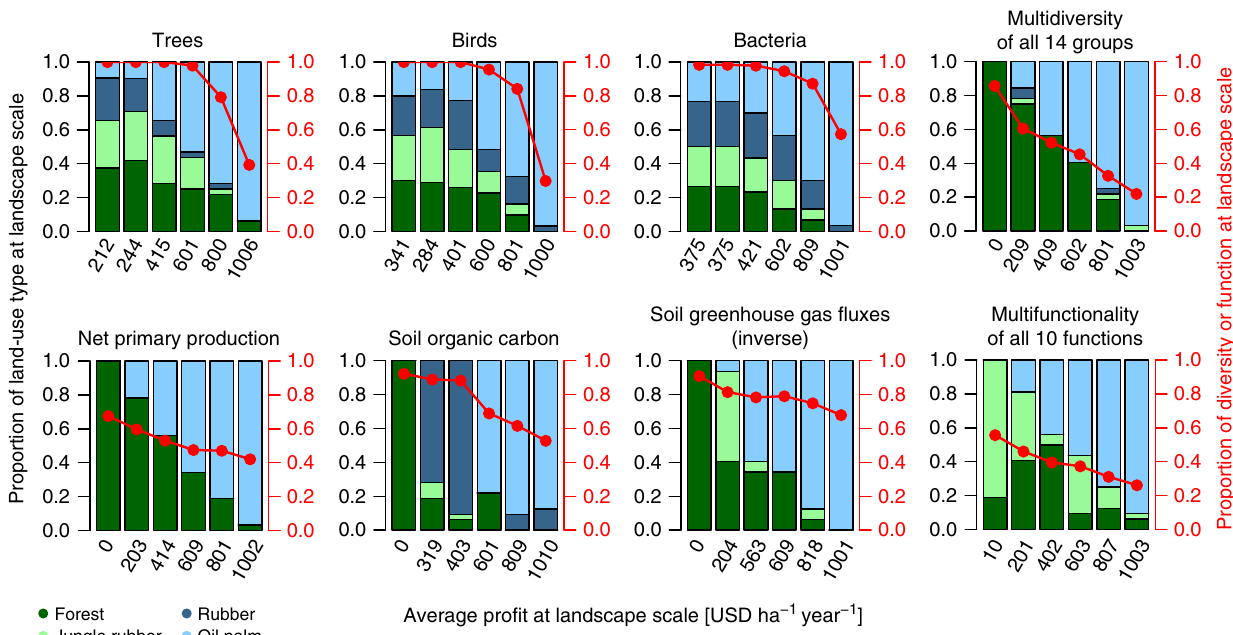
Fig. 5 Optimized landscapes for highest-possible levels of biodiversity or ecosystem functioning with increasing pro fi ts from agricultural production. Optimized landscape compositions are shown for examples of taxonomic groups and ecosystem functions as well as for multidiversity and multifunctionality considering all studied groups and functions, respectively. Each bar represents a landscape solution as identi fi ed by a genetic algorithm, fed with plot-level information on biodiversity or ecosystem functions and pro fi ts of smallholder farmers. Colors indicate the composition of landscape solutions, i.e., the proportional share of the four studied land-use systems. Red dots indicate the realized biodiversity or ecosystem function for a given landscape composition, connected by lines to visualize trends with increasing pro fi t expectations. Realized values are scaled between 0 and 1, whereby 1 corresponds to 100% of biodiversity (all sampled species present) or ecosystem functioning (all function indicators at their maximum) at the landscape level. A priori de fi ned pro fi t expectations: 0; 200; 400; 600; 800; 1000 USD ha − 1 year − 1 . Source data are provided as a Source Data fi